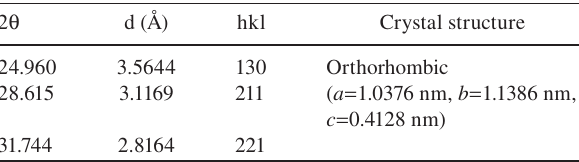
Table 1 XRD data of Bi 150 ° C for ∼ 10